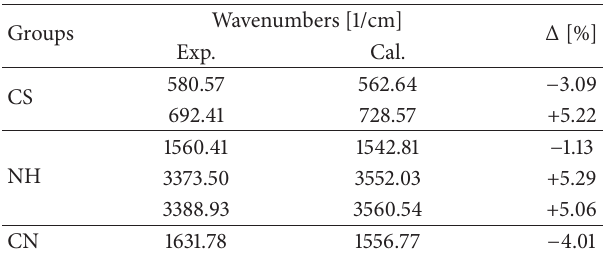
Table 2: The comparison of experimental (in Figure 2) and theoret- ical frequencies of PSTM-3T. The percentage of relative deviation of model in different frequencies is shown in parenthesis.